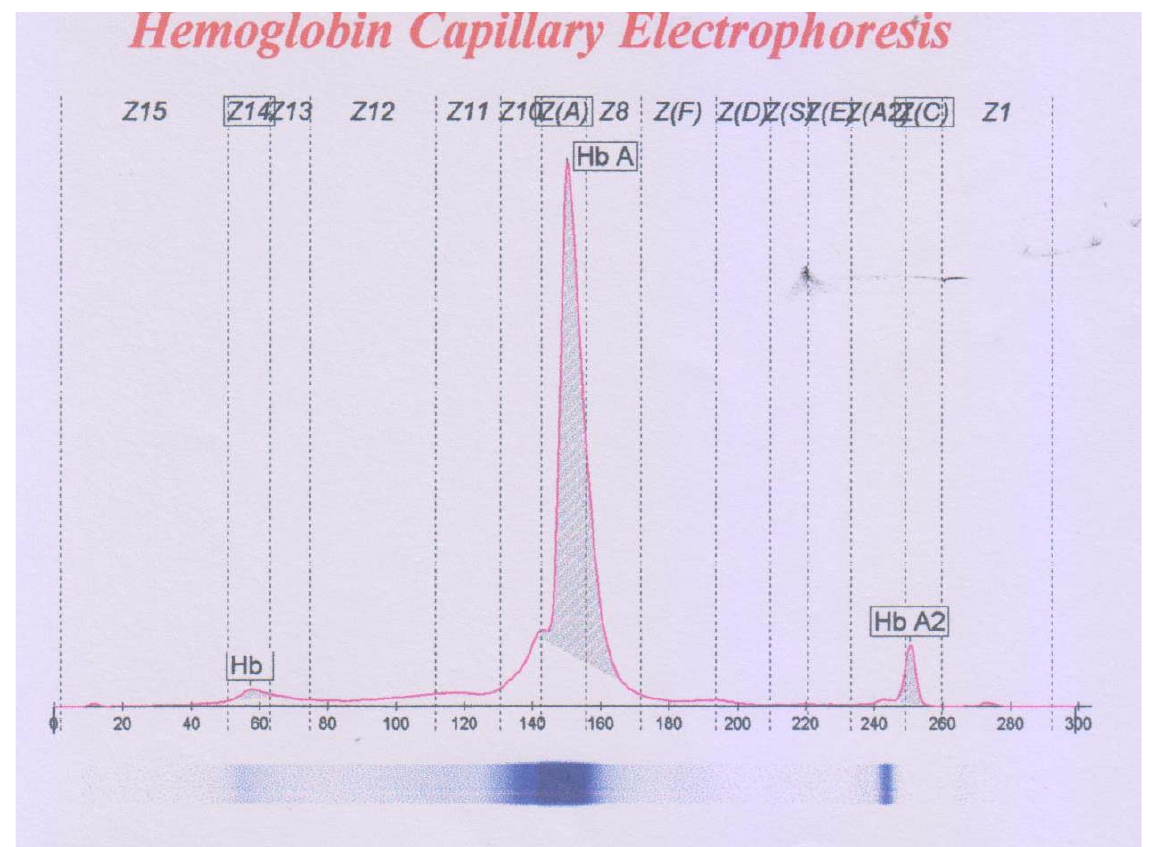
Table 1. Haematological indices of a case with co-inheritance of c.315 + 1G > A mutation of the β - globin gene and c.154G>T mutation of the α 1-globin gene.